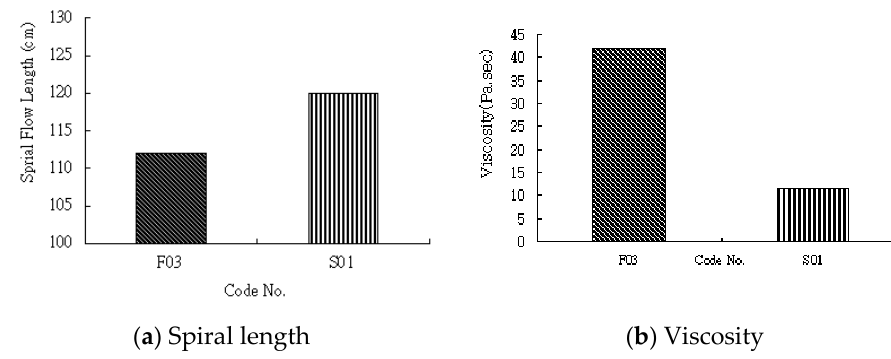
Figure 4. Filler shape effects on spiral length and viscosity of EMCs.